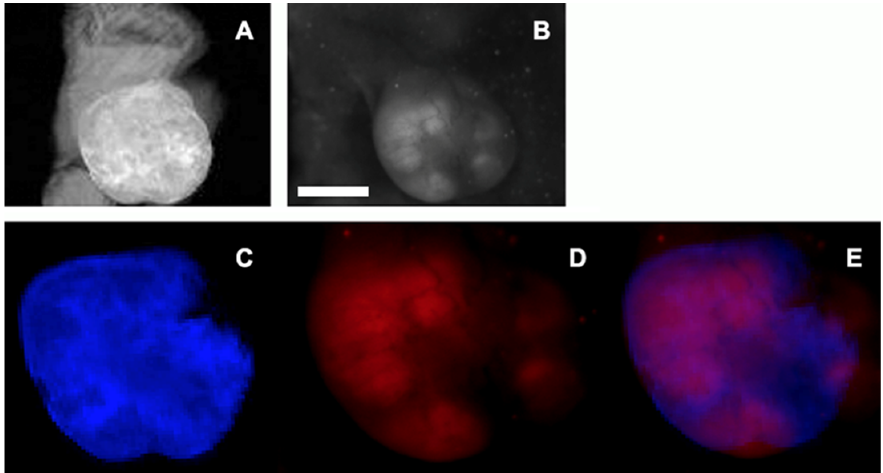
Figure 6. Representative MRI and FI imaging results obtained in an E9 xenografted mouse tumor. ( А ) 3D GRE MR image (1 T (Aspect Imaging), TR/TE = 60/2.9 ms, FA 20°, NEX = 5) 30 min after the application of 0.7 M GB, maximum intensity projection image obtained using a stack of four MRI slices; ( B ) planar FI imaging of NmdCas9-mCherry ortholog chimera; ( C – E ) a pseudo color image showing the overlay ( E ) of MRI ( C , blue) and FI ( D , red) of E9 clone-based tumor xenograft in the animal injected with 0.15 mmol/kg GB I.V.